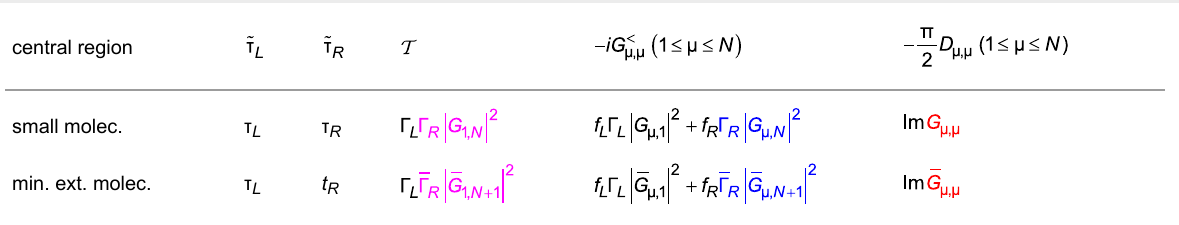
Table 1: Hopping integrals at the left and right contacts ( ), transmission function , diagonal elements of the lesser Green’s function , and the local density of states D μ , μ for the cases where either the small molecule or the minimally extended molecule (as defined in the main text) are chosen to be the central region. The quantities in the same typeface (magenta, blue, and red) color are equal (cf. Equation 19, Equation 24, and Equation